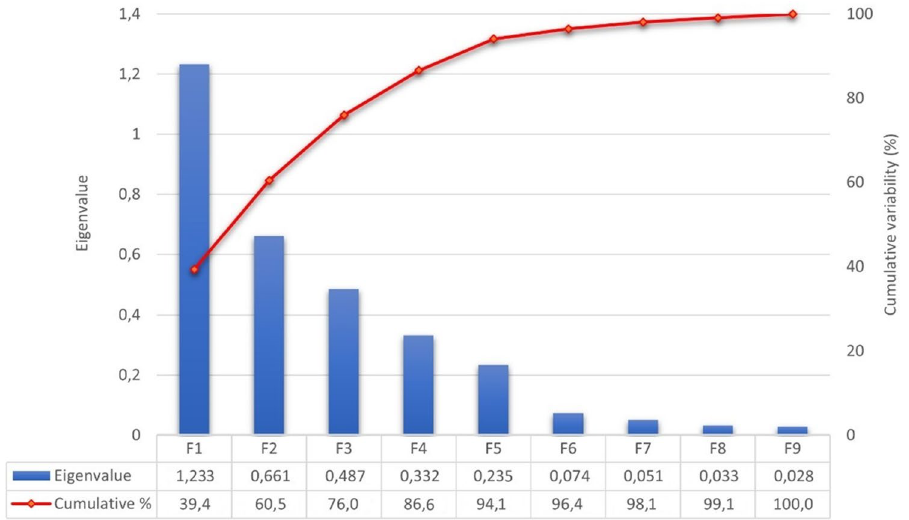
Figure 1. Canonical variable functions and percentages of self-explained and cumulative